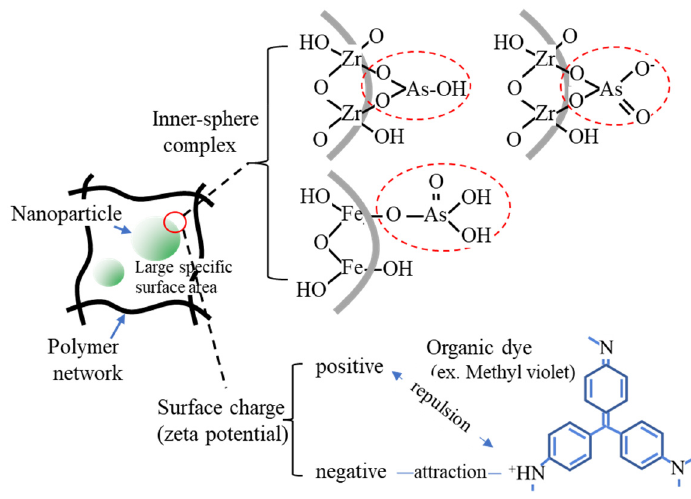
Figure 2. Examples of the adsorption mechanism on the nanoparticles.